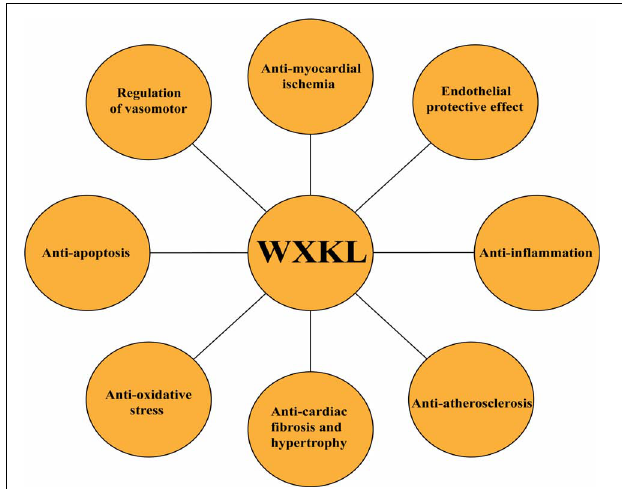
FIGURE 3 | Summary of cardioprotective functions of